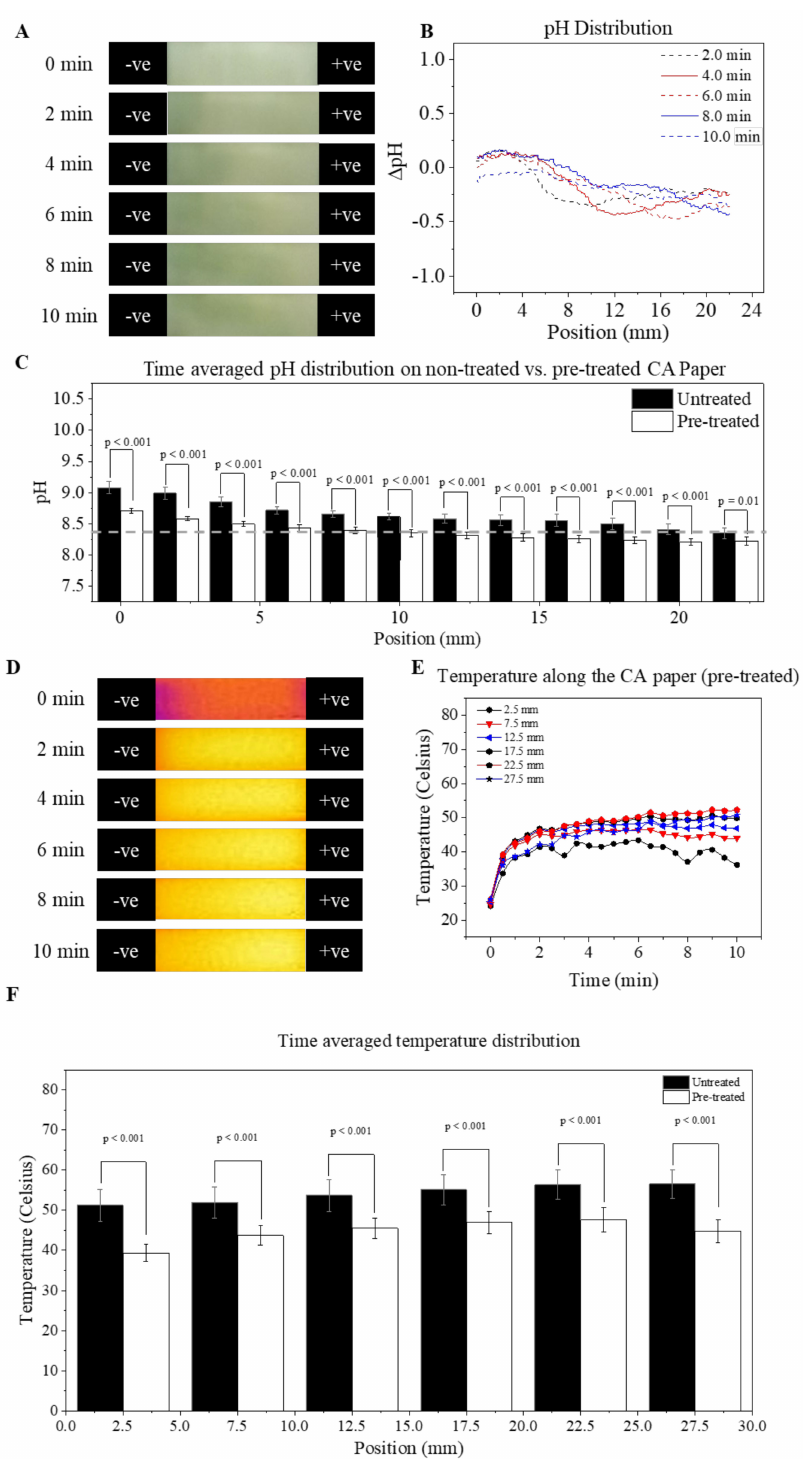
Figure 6. Thermal mapping of the pre-treated CA paper. ( A ) time-lapse of a HemeChip test run at 83.33 V/cm with a pre-treated CA paper, ( B ) pH distribution of a HemeChip test run at 8333 V/m with a pre-treated CA paper, ( C ) time-averaged pH distribution comparison between a treated and non-treated CA paper, ( D ) temperature distribution of a HemeChip test run at 83.33 V/cm with a pre-treated CA paper, ( E ) yaxis-averaged temperature distribution along the x-axis of a pre-treated CA paper, and ( F ) time averaged temperature distribution comparison between an untreated and a pre-treated CA